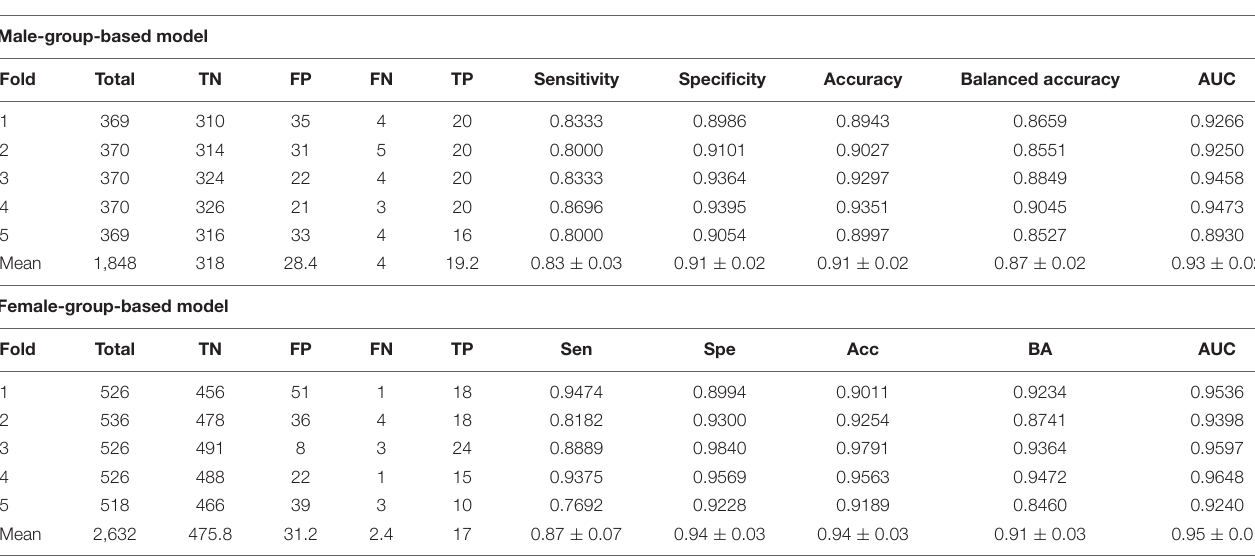
FIGURE 3 | Cross-validation performance using the metrics of AUC and balanced accuracy: (A) male group and (B) female group. AUC, area under the curve. TABLE 3 | Cross-validation results (mean ± SD) from male- and female-group